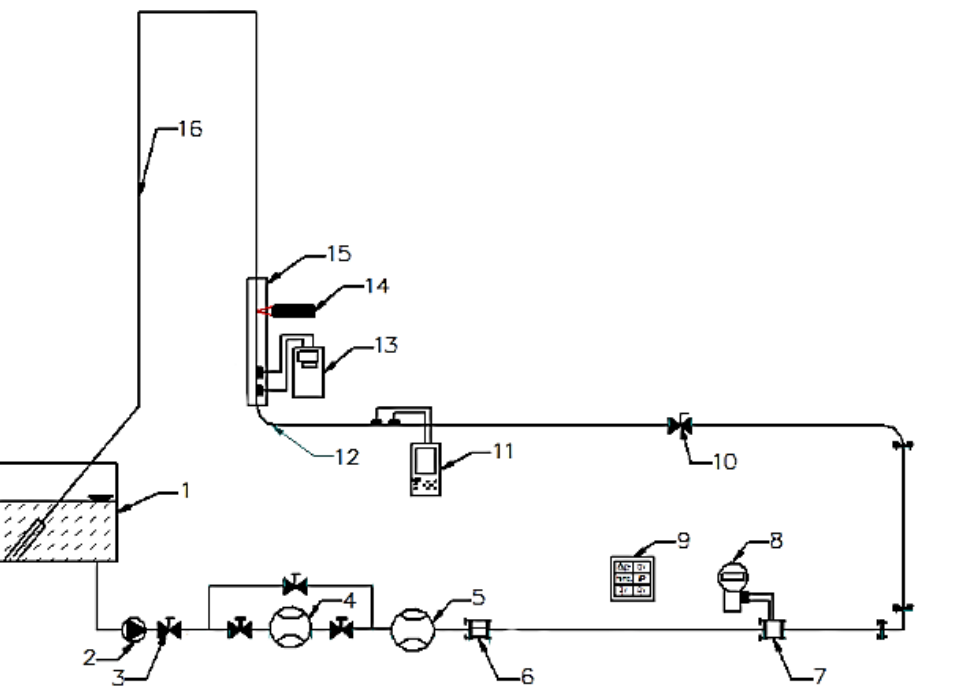
Figure 1. Experimental stand. 1—container with water; 2—pump; 3—control valve; 4—coupled water meter; 5—electromagnetic flow meter; 6—stream straightener; 7—ISA orifice with annular chamber pressure tapping; 8—pressure transducer; 9—programmable current recorder; 10—throttle; 11—reference ultrasonic flow meter measuring in an undisturbed area; 12—90° bend with radius R = 2D; 13—ultrasonic flow meter measuring in an area of disturbed flow; 14—LDA laser Doppler anemometer; 15—correction vessel; 16—return recirculator pipeline. Description in the text.